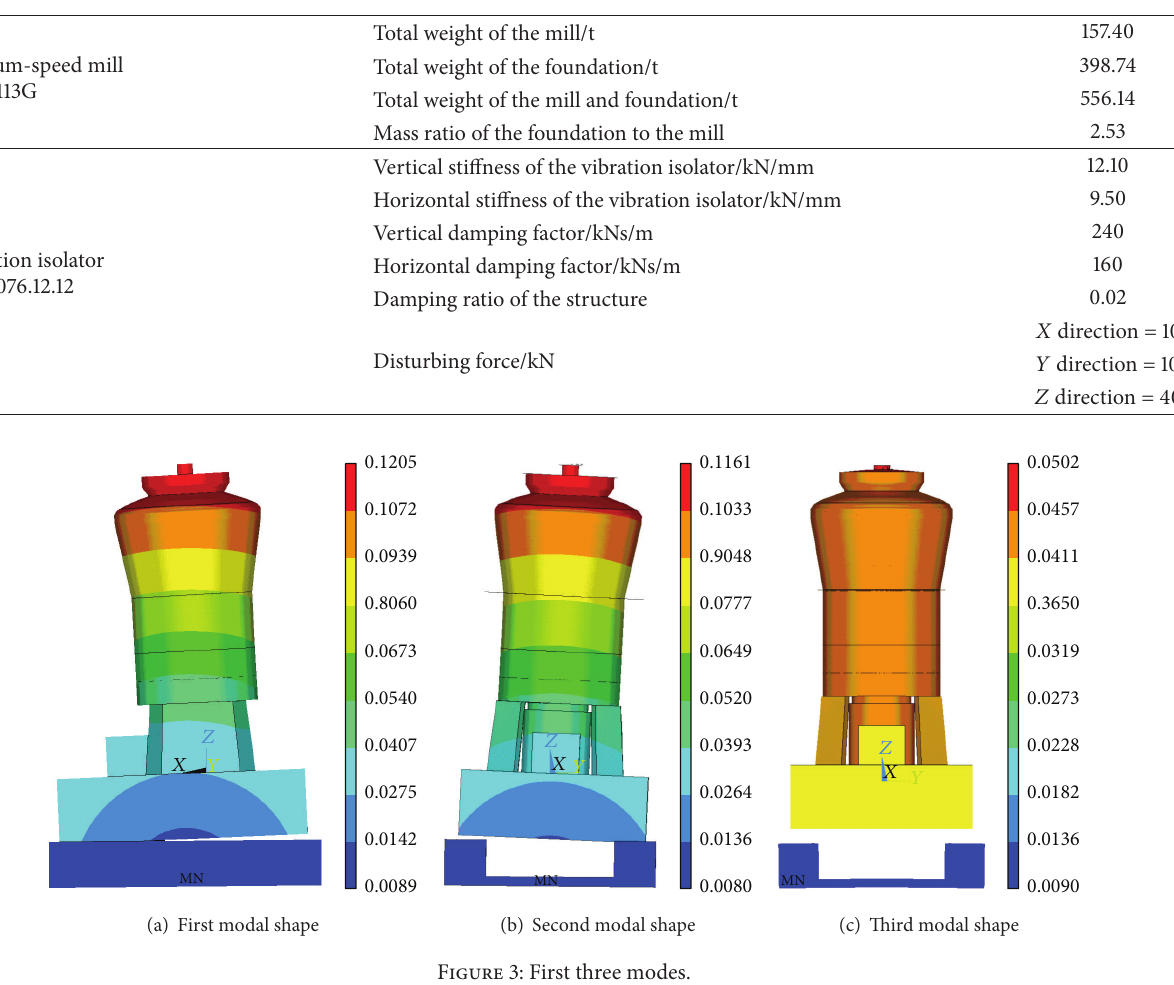
Table 1: Parameters of the mill and vibration isolator.